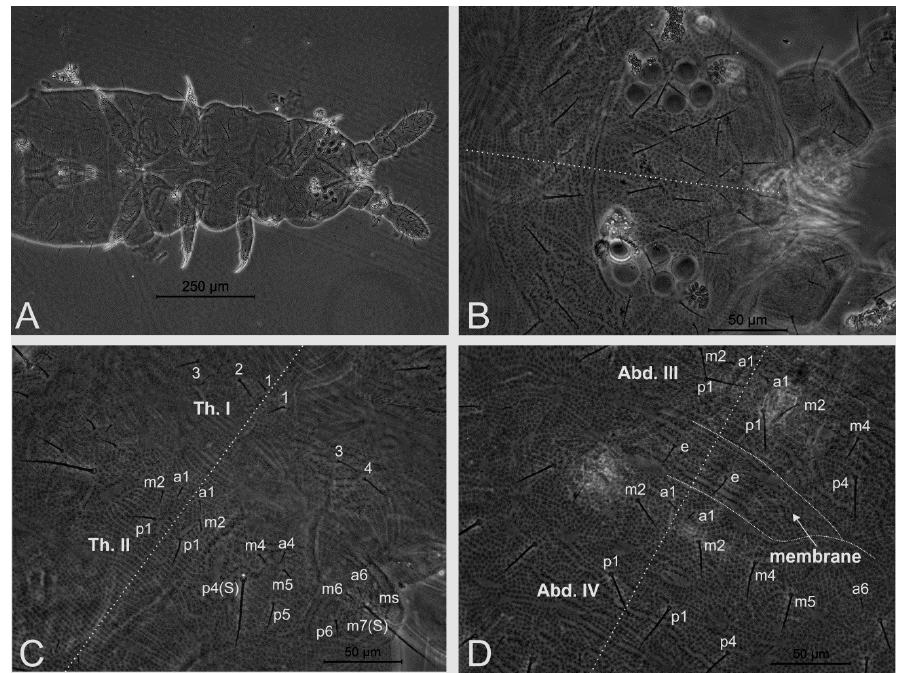
Figure 1. Neotropiella arretada sp. nov. holotype: ( A ) partial habitus (Abd. V and VI omitted); ( B ) dorsal head; ( C ) Th. I–II dorsal chaetotaxy ( m2 absent on right side of Th. I, S = long sensilla); ( D ) Abd. III–IV partial dorsal chaetotaxy plus intersegmental membrane (e = extraordinary chaetae). Midline drawn over ( B – D